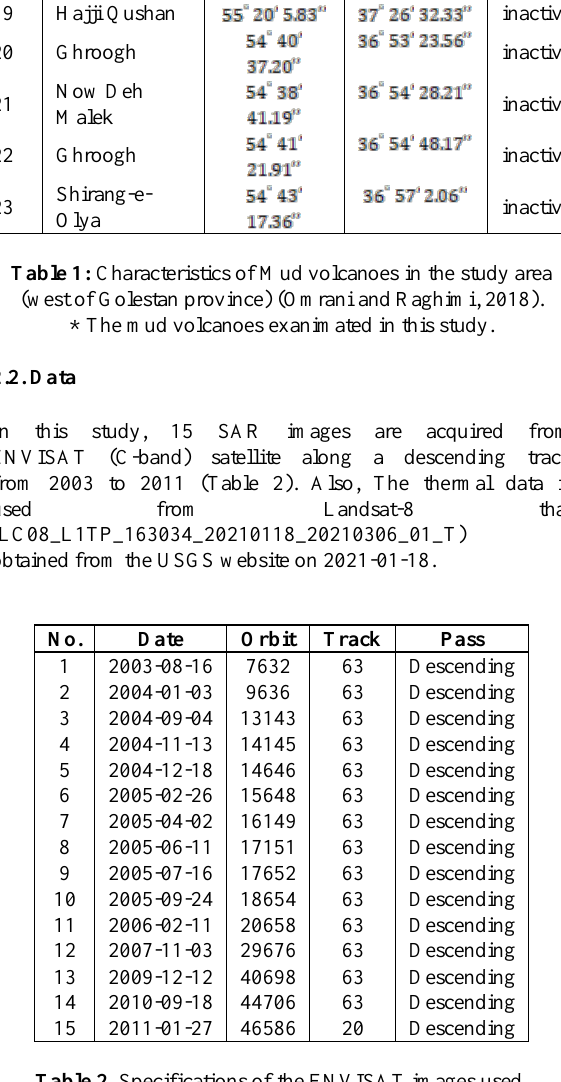
Table 2 . Specifications of the ENVISAT images